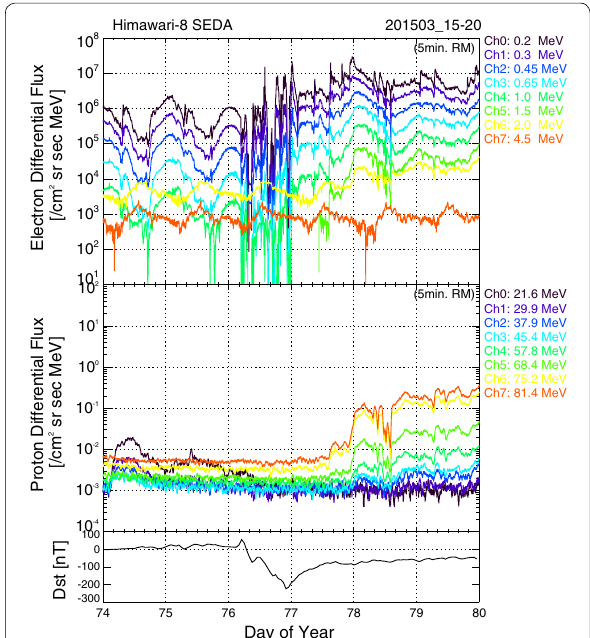
Fig. 2 Himawari-8/SEDA observations on March 15–20, 2015. The 5-min running mean of SEDA-e and SEDA-p differential fluxes in eight channels are plotted in the top and second panels , respectively. The Dst index is plotted in the bottom panel